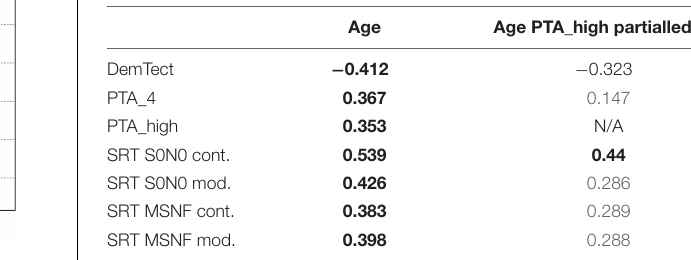
FIGURE 5 | Speech reception thresholds for the continuous noise (cont., filled boxes) and modulated noise (mod., hatched boxes) in spatial conditions S0N0 and multi-source noise field (MSNF). Gray boxes: seniors (present study), white boxes: data of young adults with normal hearing ( n = 14, mean age: 26.4 ± 5.4 years, range: 22–37.3 years) using the identical test setup (Weissgerber et al., 2017). * Outliers 3 times greater than interquartile range.